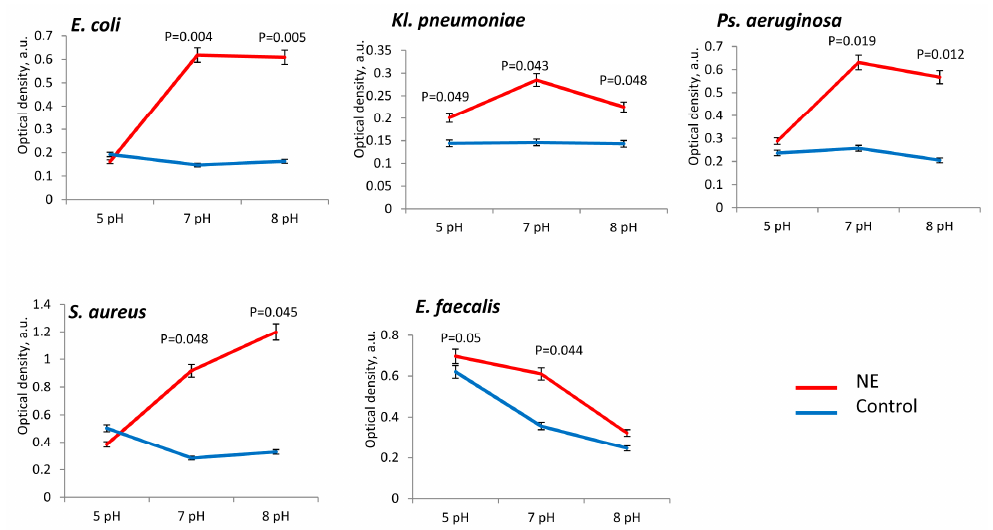
Figure 1. Biomass production of uropathogenic microorganisms is influenced by pH and the presence of NE in PBS.